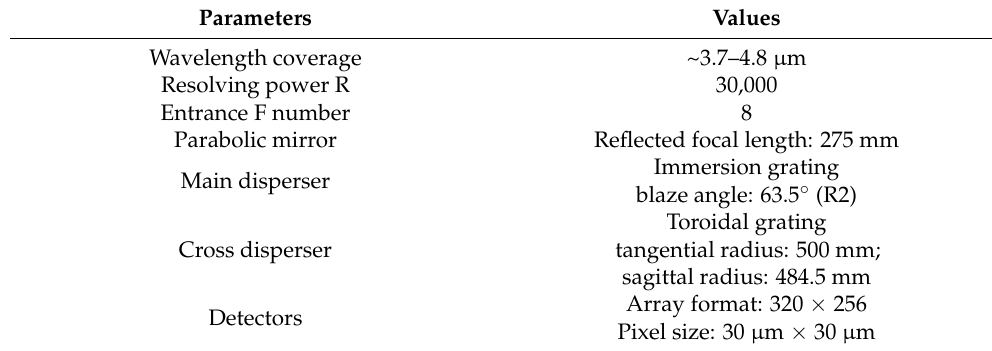
Table 3. The parameters designed for the optic